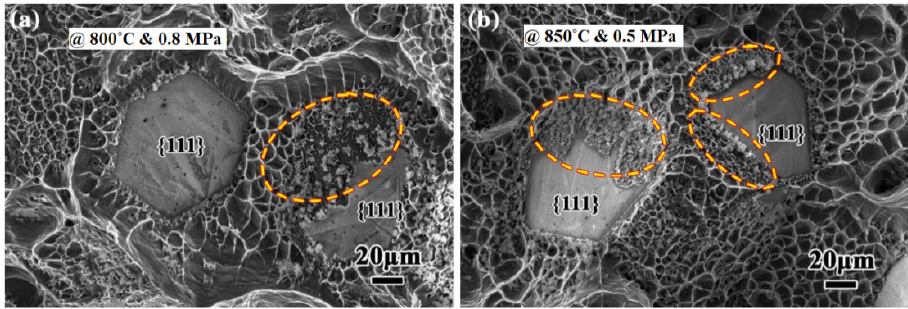
Figure 8. SEM micrographs demonstrating the occurrence of the diffusion reaction on the partial {111} faces of diamond particles in the gas pressure-infiltrated Al/diamond composites: ( a ) 800 °C and 0.8 MPa; ( b ) 850 °C and 0.5 MPa [126].